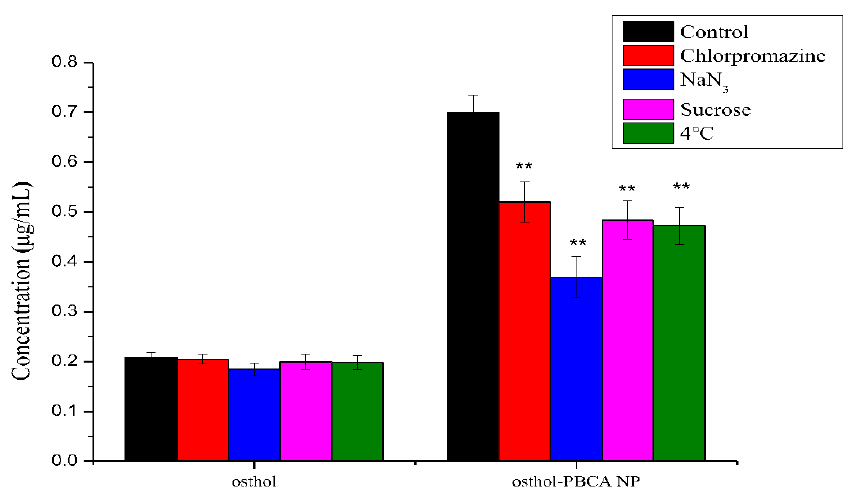
Figure 7. The uptake process of osthol and osthol-PBCA NPs in SH-SY5Y cells using endocytosis inhibitors or at a low temperature (** p < 0.01 vs. osthol group). inhibitors or at a low temperature (** p < 0.01 vs. osthol